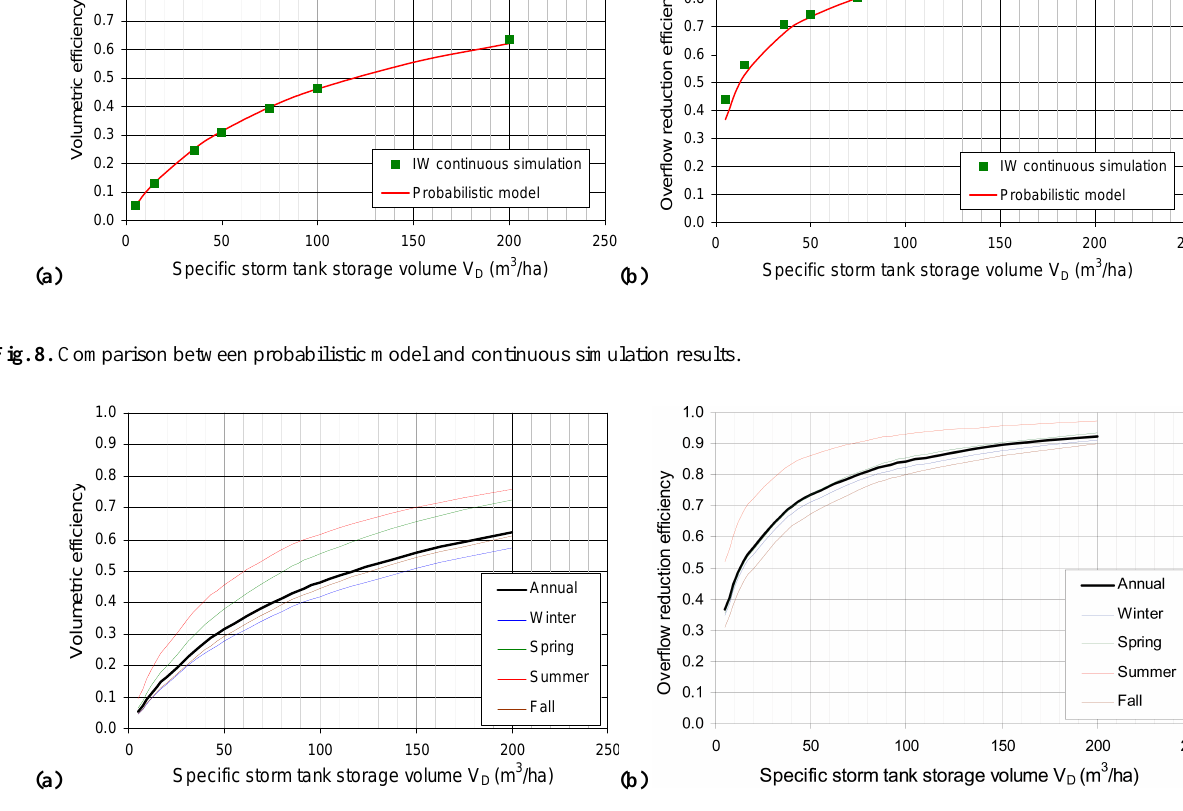
Fig. 9. Comparison between annual and seasonal results for the analytical